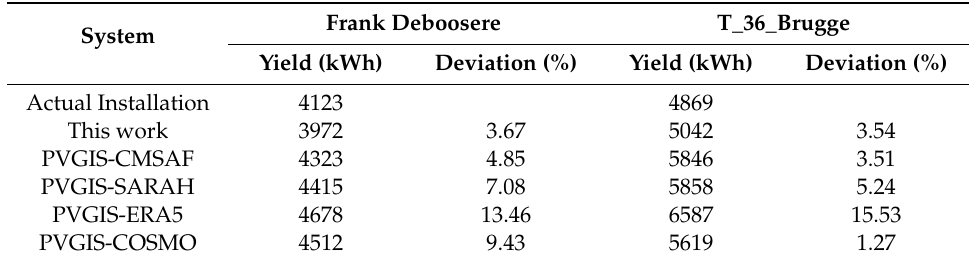
Table 3. Annual yield of actual installation PV systems compared to the results of this work and other